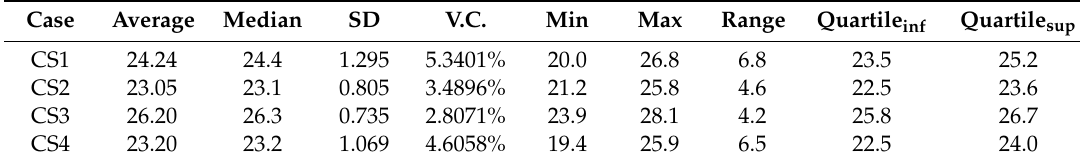
Table 5. Temperature statistics ( ◦ C) during